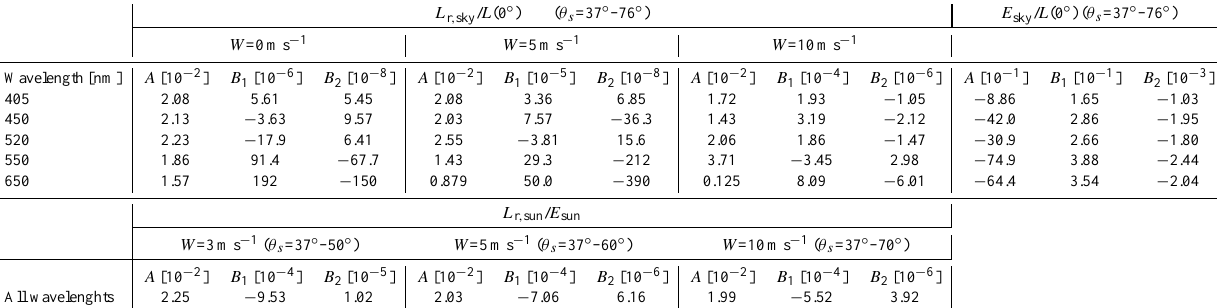
Table 5. Polynomials for L r , sky / L (0 ◦ ), L r , sun / E sun , and E sky / L (0 ◦ ) on the form A + B 1 θ s + B 2 θ 2 s , where θ s is in units of degrees.